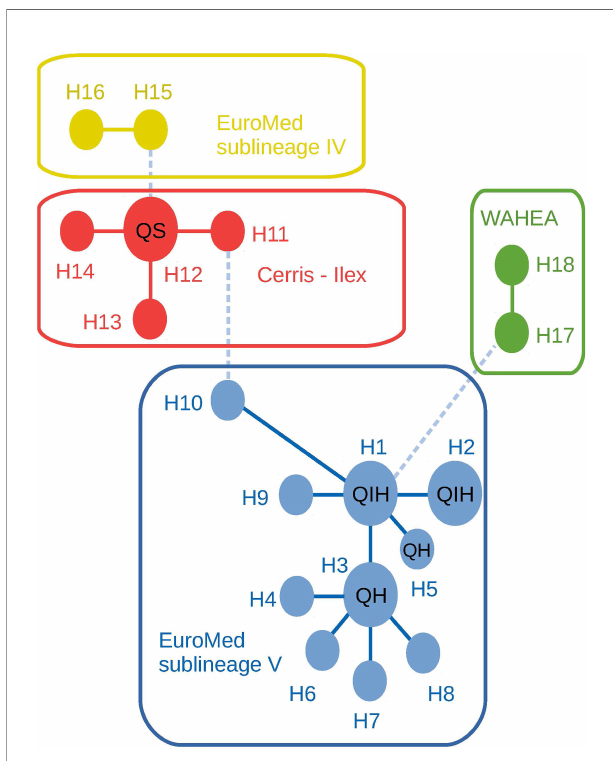
FIGURE 2 | Median-joining haplotype network of trnH-psbA marker combining the investigated samples and published haplotypes of each major Ilex and Cerris lineages. Lineage and sub-lineage identity according to Vitelli et al., 2017 and Simeone et al., 2018. WAHEA: haplotypes from the West Asian, Himalayan, and East Asian lineages. Line types correspond to the number of mutations separating each haplotype: solid lines = 1 – 3 mutations; dashed lines 6 – 10 mutations. Coding within haplotype circles indicate the presence of samples of the present work: QS, Adult Q. suber individuals; QIH, Adult Q. ilex and hybrid individuals; QH, only hybrid